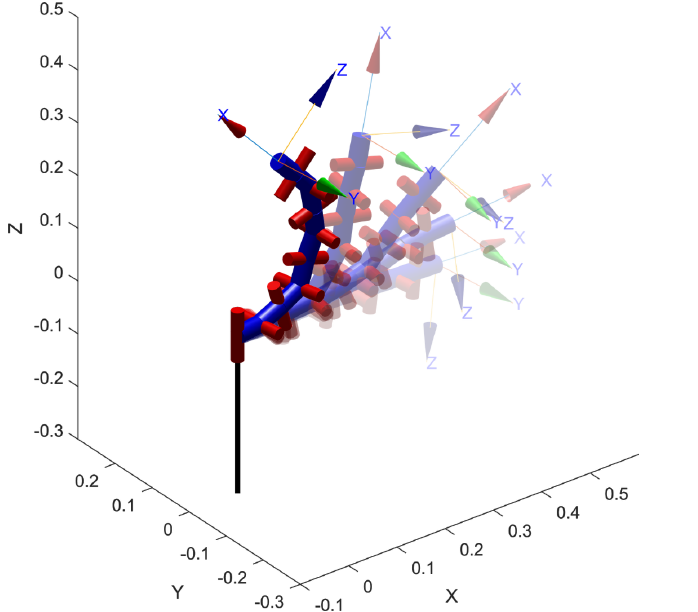
Figure 8. In this simulation run, the controller attempted to actuate the robot to a back arching configuration. It achieved to reach this configuration within 150